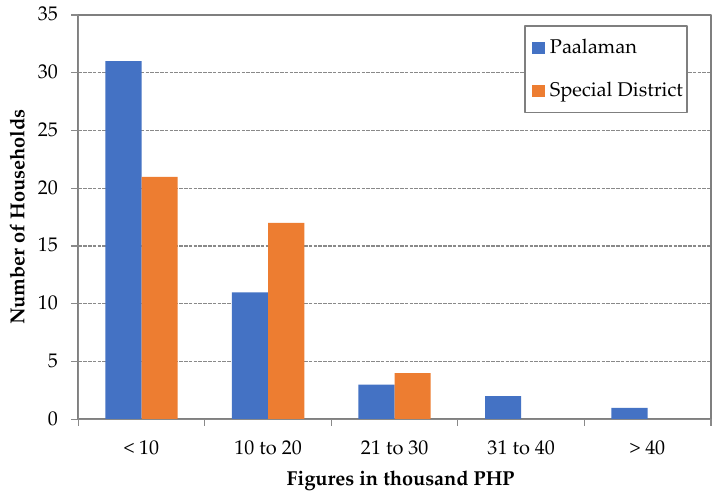
Figure 5. Percentage of average monthly income in the surveyed households (N = 90).